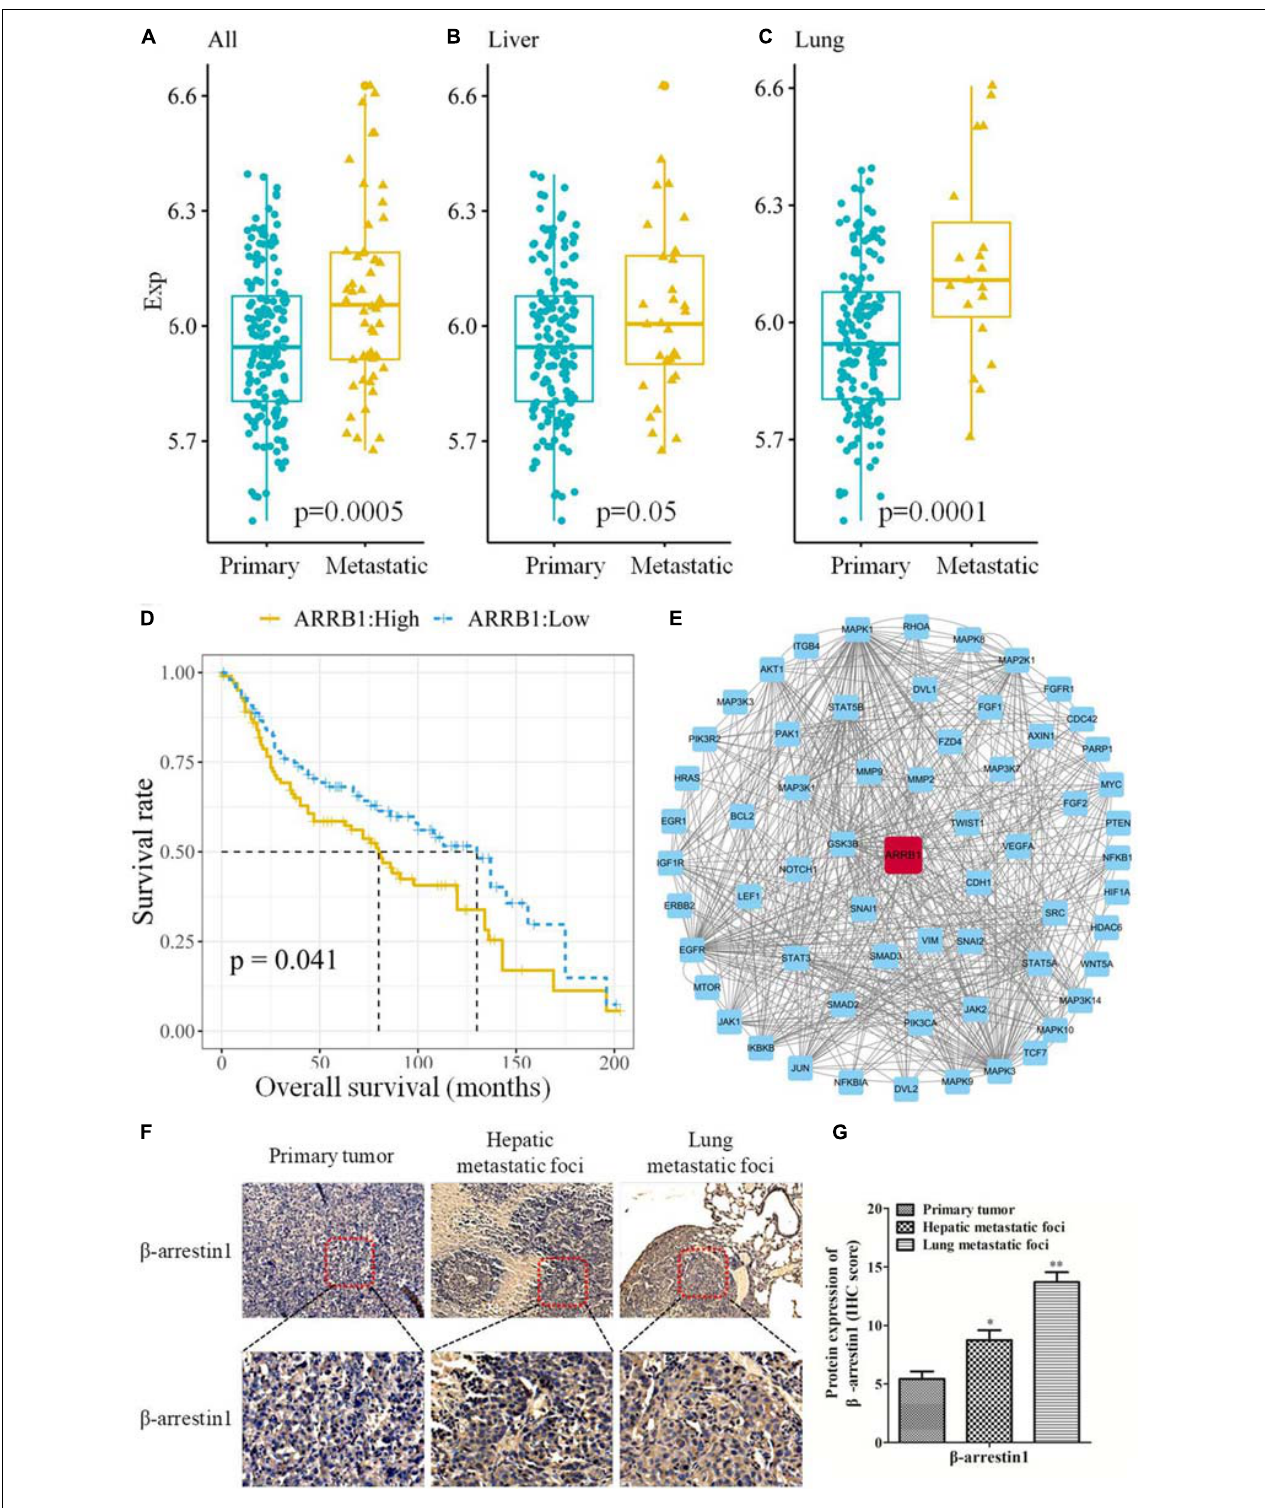
FIGURE 1 | Expression of β -arrestin1 in CRC tissues and its association with the prognosis of patients with CRC. (A–C) Analysis of β -arrestin1 expression profile using data from the GSE41258 dataset. (D) Association between β -arrestin1 expression and the prognosis of patients with CRC. (E) Network representation of β -arrestin1 interactions with multiple genes, including Twist, Snail, CDH1, Vimentin, MMP2, MMP9, GSK-3 β , MAPK, etc. (F–G) Immunohistochemical and quantitative analysis of β -arrestin1 protein in representative CRC and metastatic lung/liver tissues (scale bars, upper row: 200 µ m, down row: 50 µ m, respectively). * P < 0.05; ** P < 0.01 vs. Primary